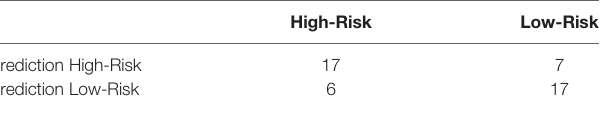
TABLE 3 | Confusion matrix for the prediction images with AI diagnosis.